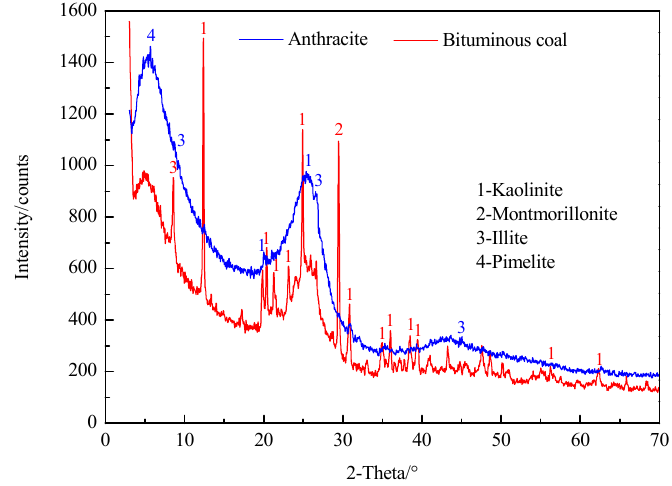
Figure 1. XRD pattern of anthracite and bituminous coal.